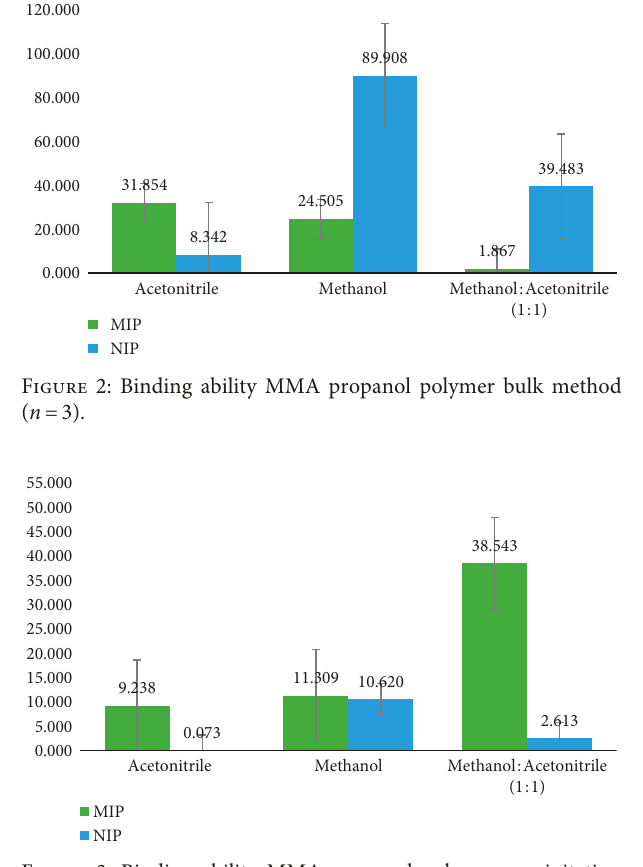
Figure 3: Binding ability MMA propanol polymer precipitation method ( n � 3).